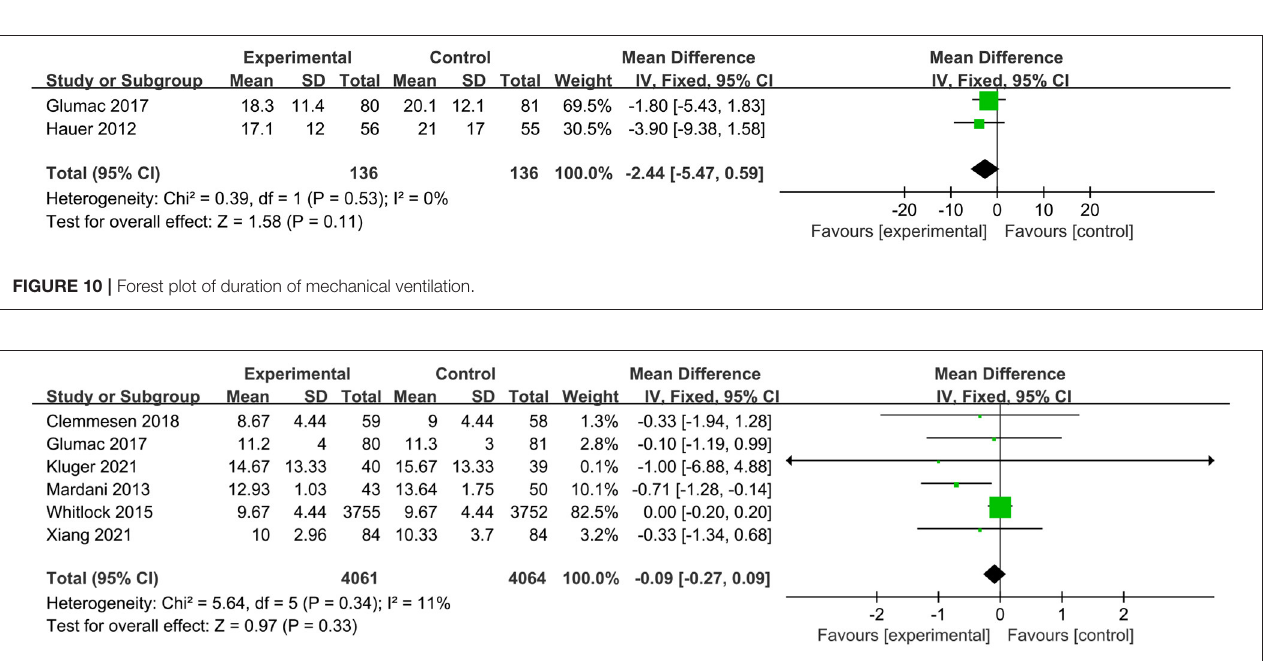
FIGURE 9 | Forest plot of postoperative blood glucose level.